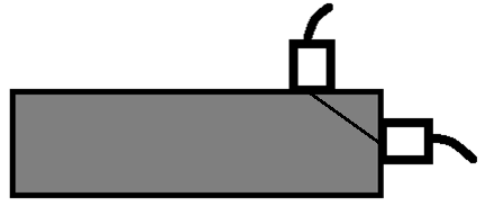
Figure 6. Indirect UPV measurement.